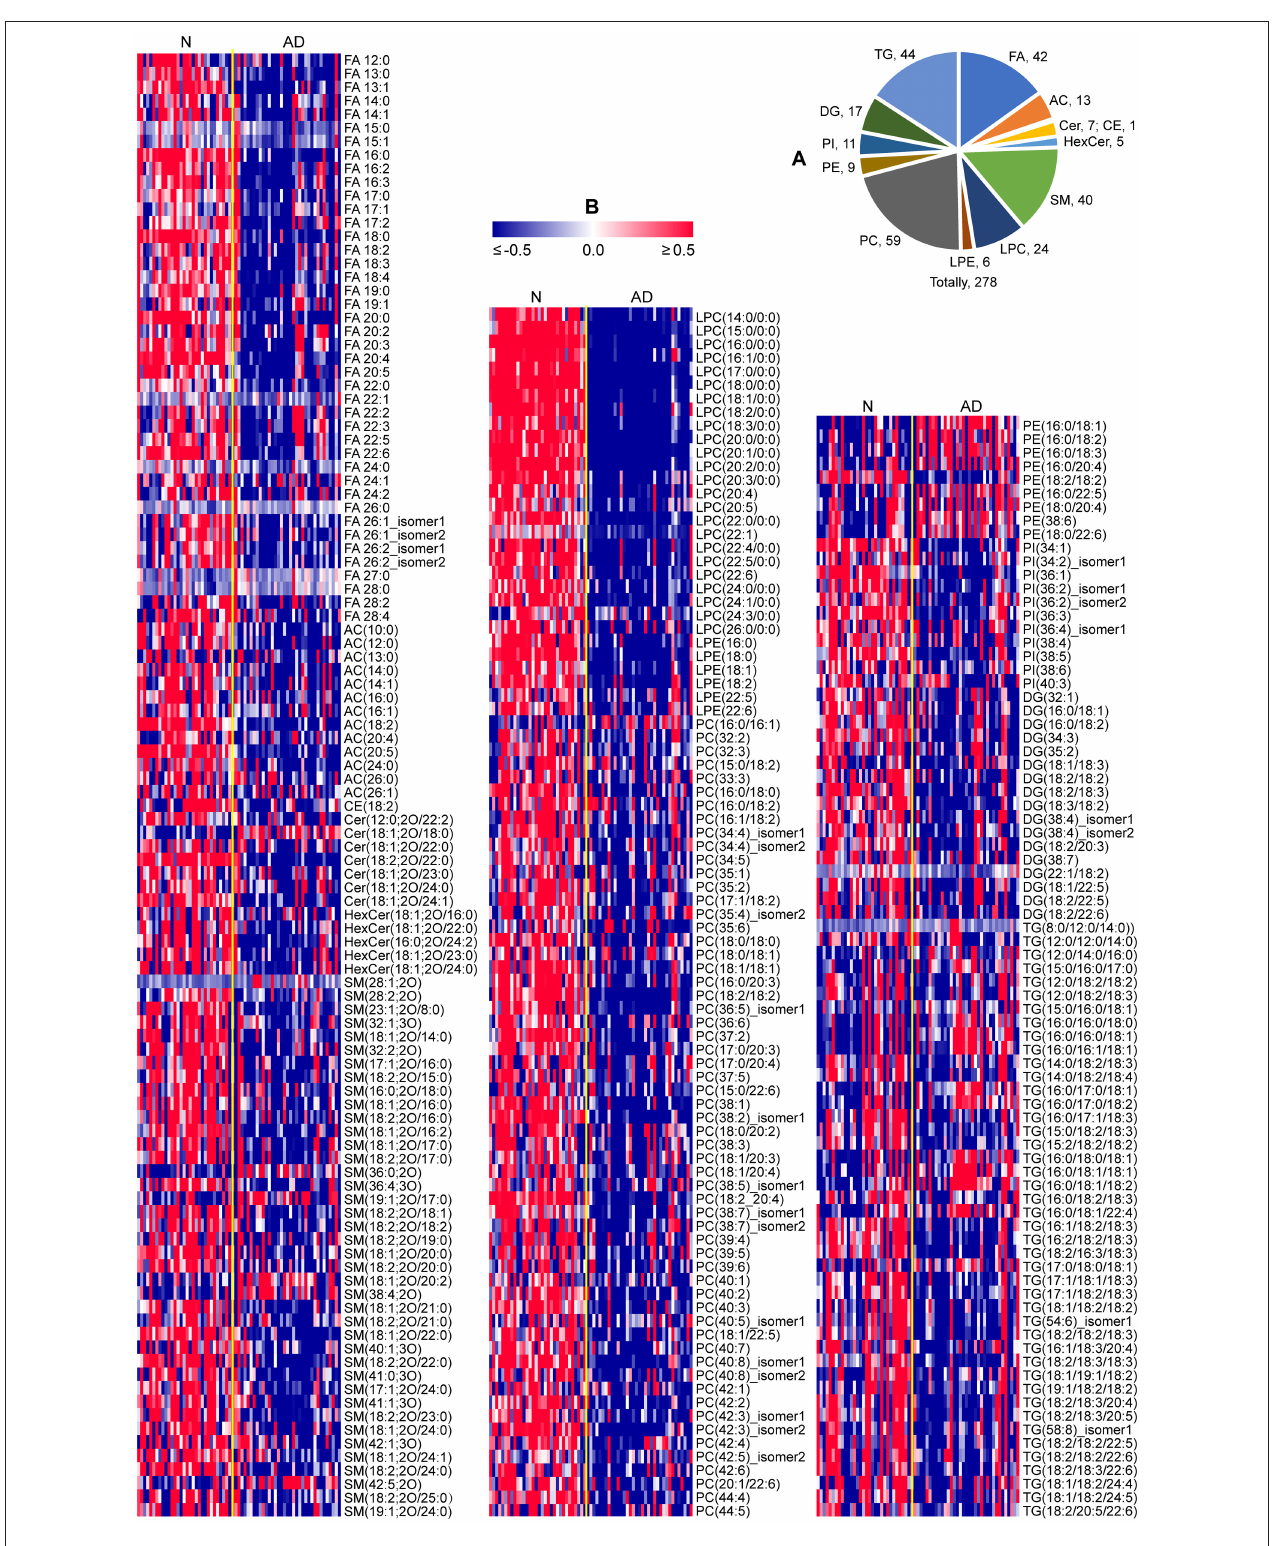
FIGURE 2 | Characteristic lipid metabolism in patients with AD. (A) Pie chart indicating the number of lipids significantly altered in patients with AD ( P < 0.05, two-tailed Mann-Whitney U test). (B) Heat map plot of lipid alterations in patients with AD. Red/blue color: high/low abundance. n = 32 and 35 in the normal (N) and AD group, respectively. FA, fatty acid; AC, acyl carnitine; CE, cholesteryl ester; Cer, ceramide; HexCer, hexosylceramide; SM, sphingomyelin; LPC, lysophosphatidylcholine; LPE, lysophosphatidylethanolamine; PC, phosphatidylcholine; PE, phosphatidylethanolamine; PI, phosphatidylinositol; DG, diglyceride; TG,